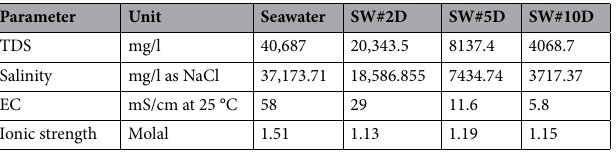
Table 9. TDS, salinity, EC, and IS values of mixing diluted waters with different compositions of the Persian Gulf as IW with FW.